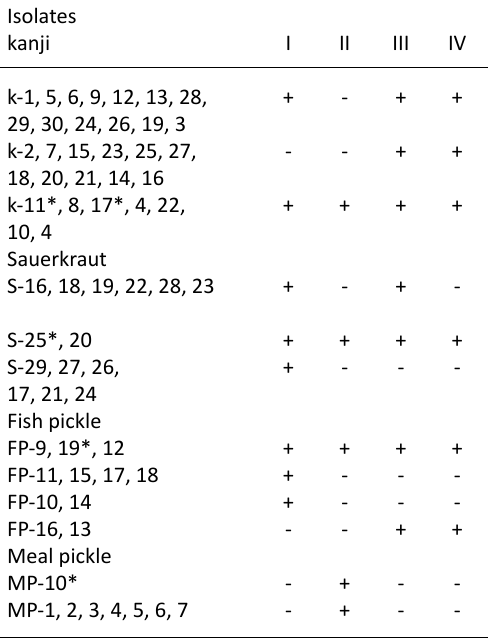
Fig. 1. Isolates showing positive for BAs production in MDA and